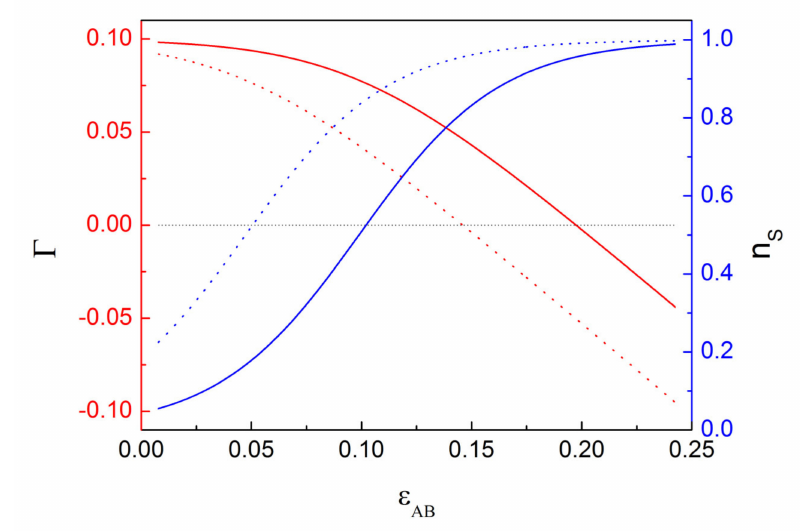
Figure 1. E ff ective surface energy Γ (red) and concentration n S of surfactant molecules (B) on particle surface (blue) as functions of A–B bonding ε AB for two values of the bulk concentration of surfactant n S = 0.002 (solid) and n S = 0.01 (dotted) plotted according to Equation (2) for γ = 0.01 eV and T = 0.032